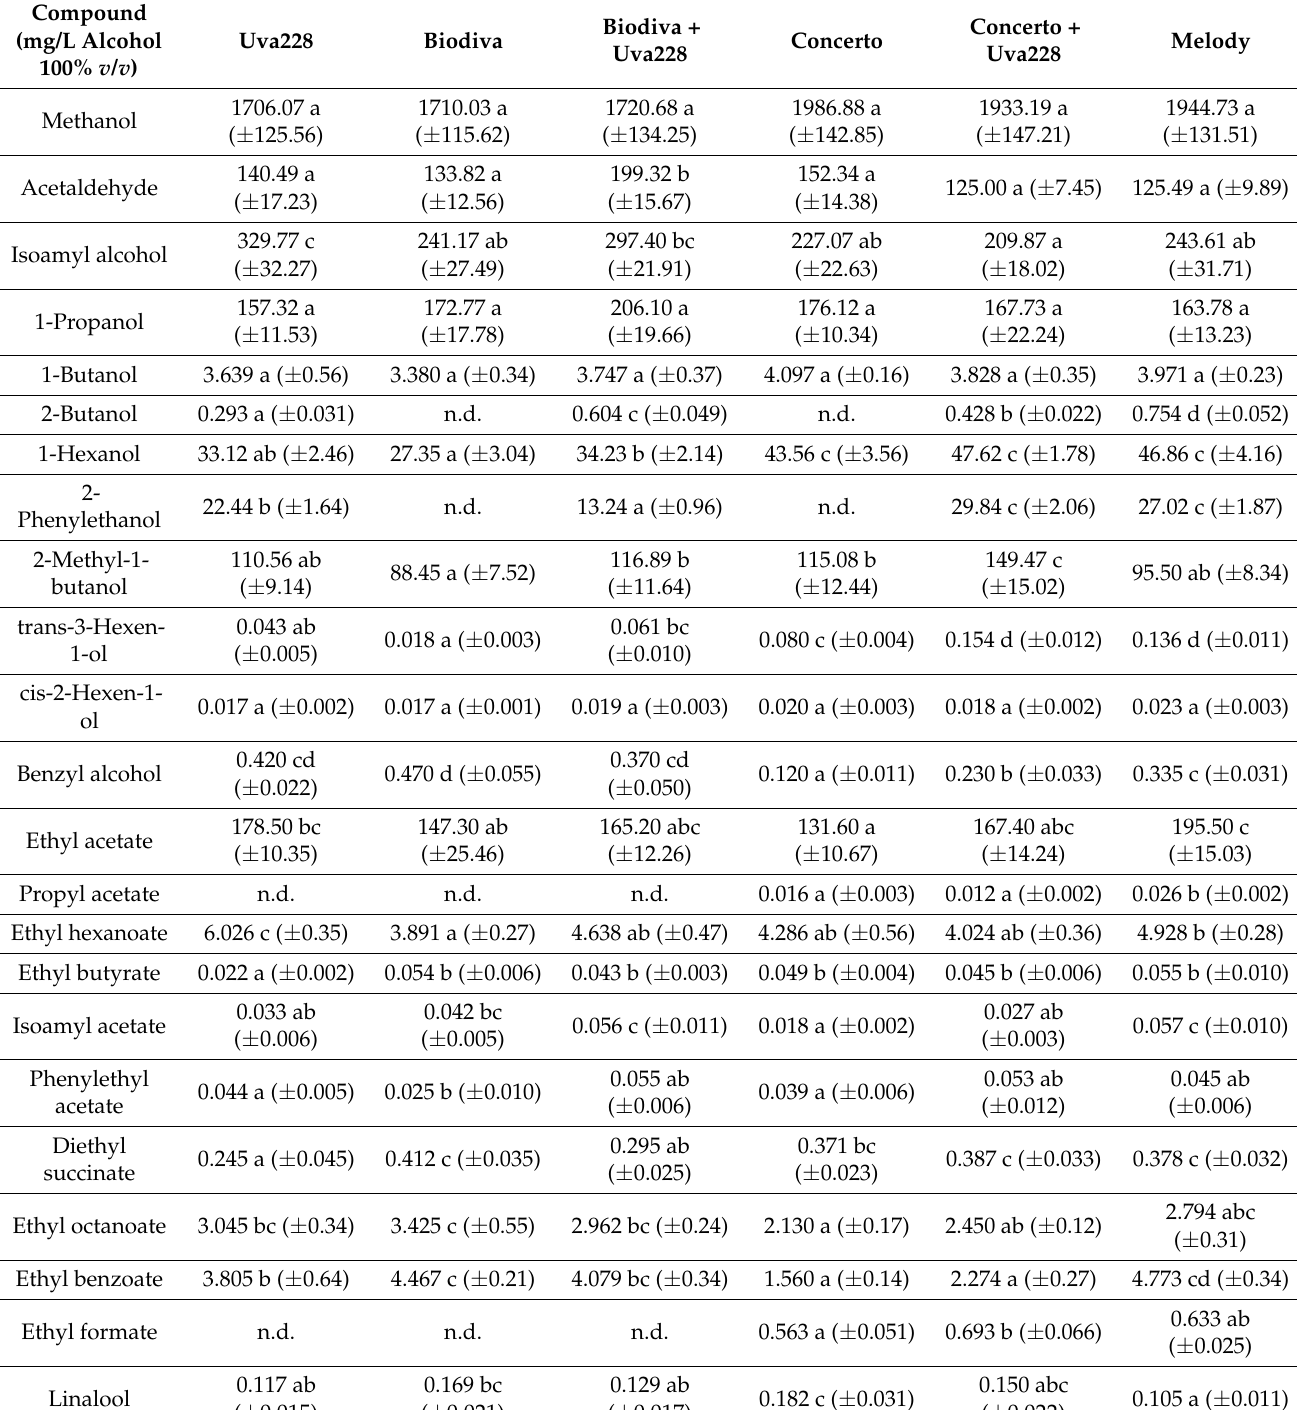
Table 2. Volatile aroma compounds identified in the apple